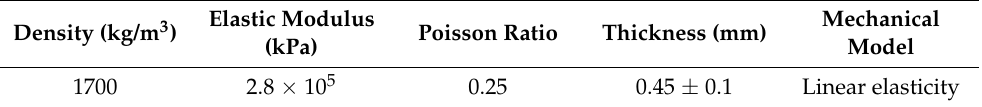
Table 5. Simulated parameters of